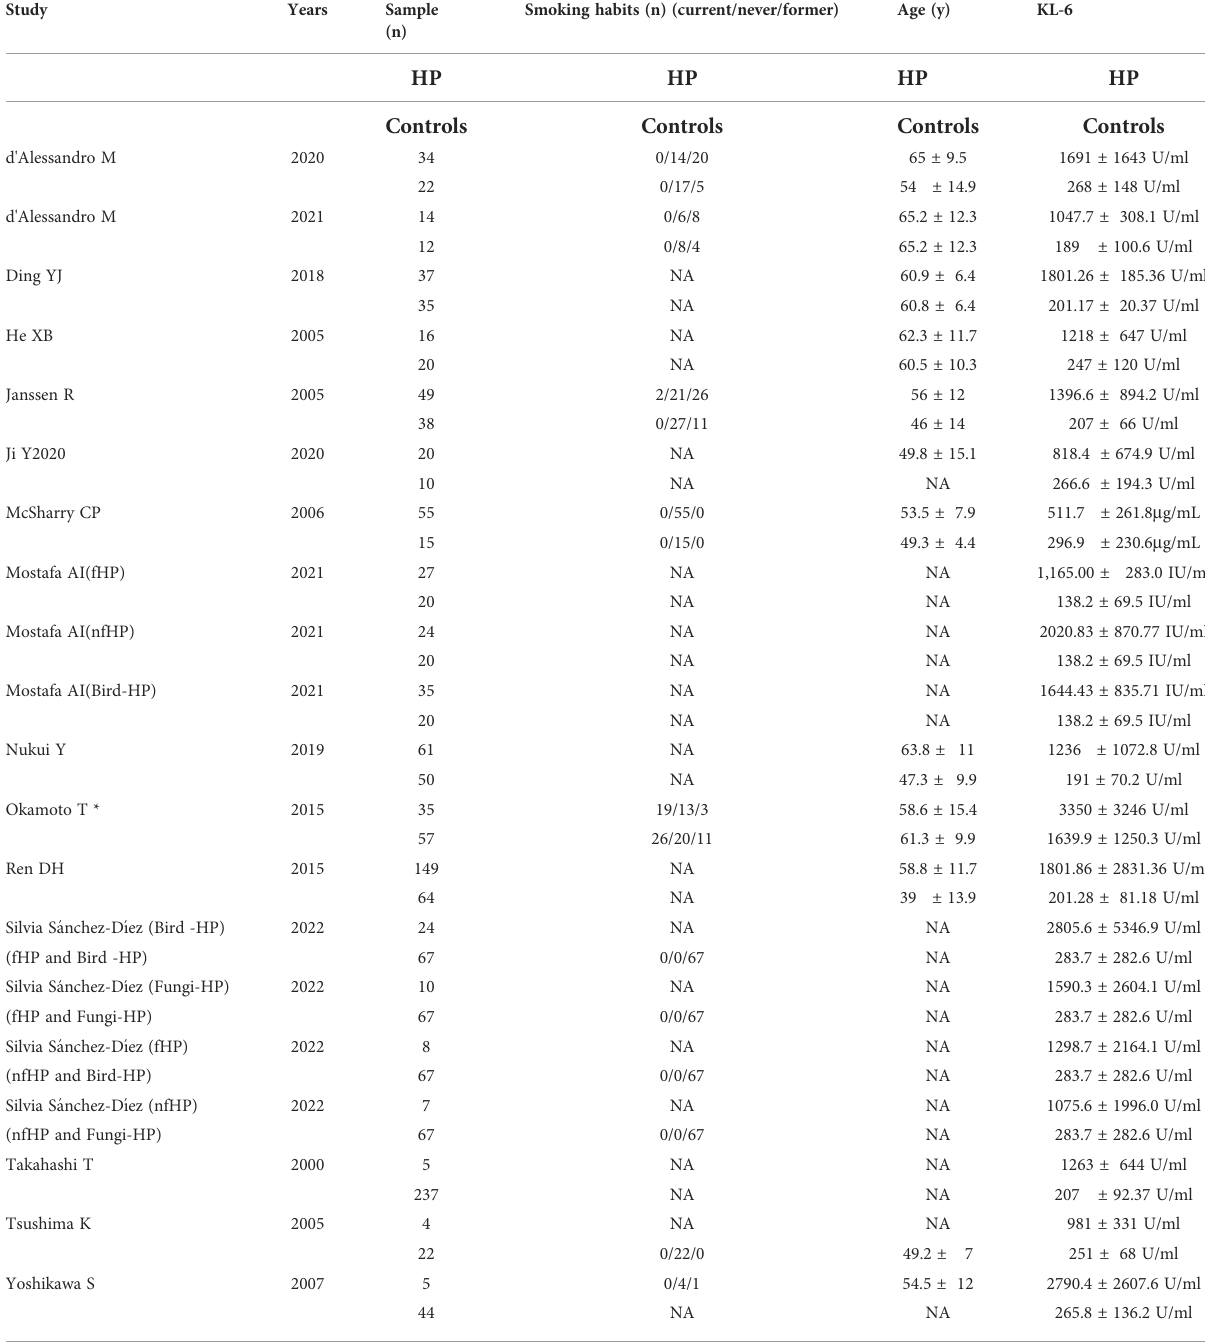
TABLE 2 Participants ’ characteristics of included